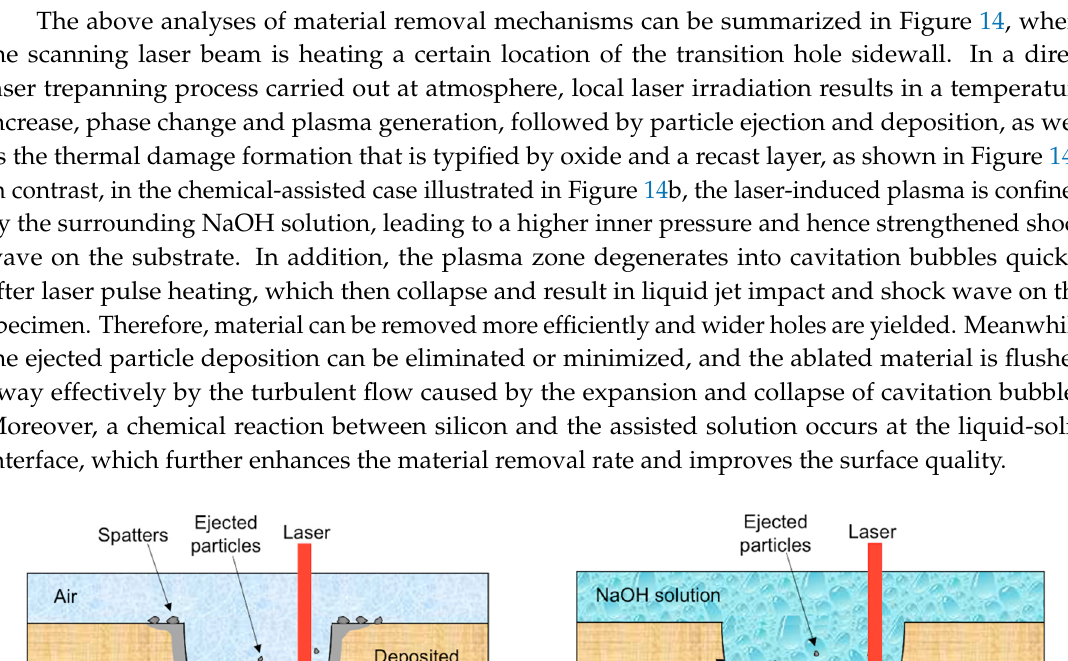
Figure 13. Exit details of the chemical-assisted micro-trepanning results, where ( a ) is an overall view, while ( b ) shows the details within the red square. The processing parameters include: P = 18.5 W, f = 0.4 MHz, v = 600 mm/s, n = 20, m = 120; and a NaOH solution with a concentration of one mol/L was used in the chemical-assisted laser processing.